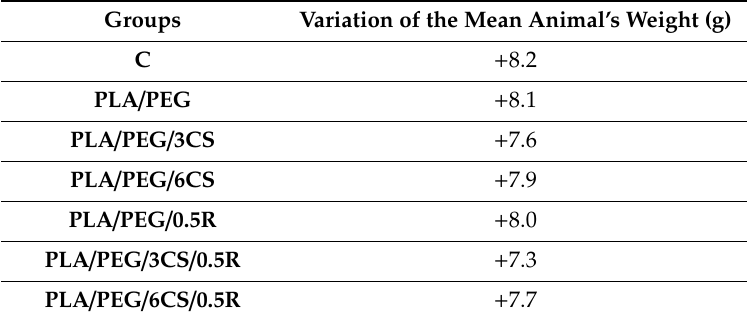
Table 8. The influence of biocomposite implants on the animals body weight after seven days.